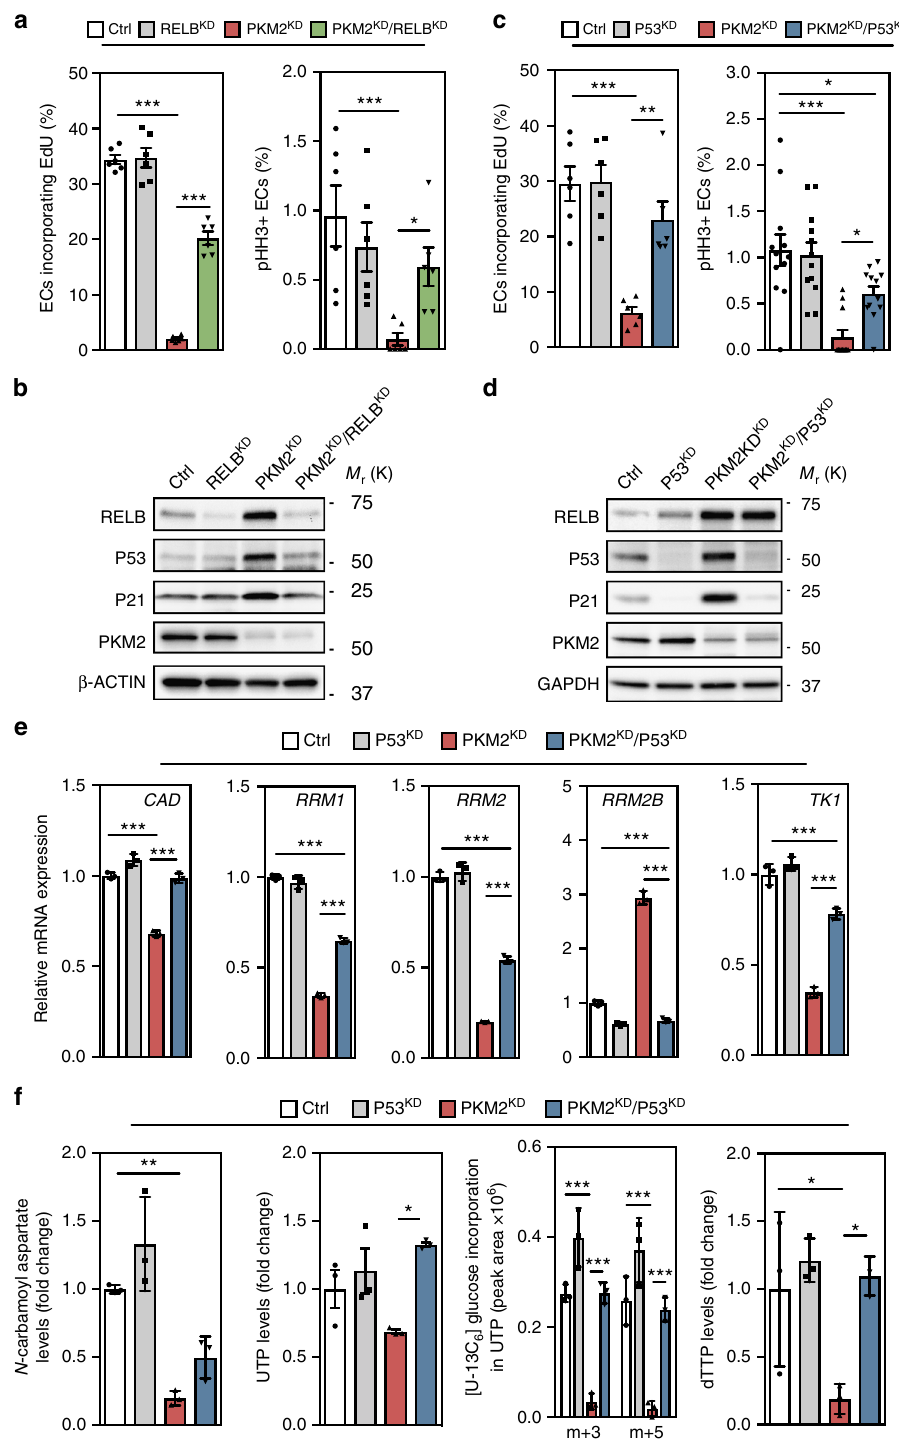
Fig. 5 RELB-P53 suppresses endothelial growth in the absence of PKM2. a EdU and phospho-Histone H3 positive cell numbers in control, RELB KD , PKM2 KD and PKM2 KD /RELB KD ECs ( n = 6). b Western blot analysis of RELB, P53, P21 and PKM2 expression in control, RELB KD , PKM2 KD and PKM2 KD /RELB KD ECs. c EdU and phospho-Histone H3 positive cell numbers in control, P53 KD , PKM2 KD and PKM2 KD /P53 KD ECs ( n = 12). d Western blot analysis of RELB,